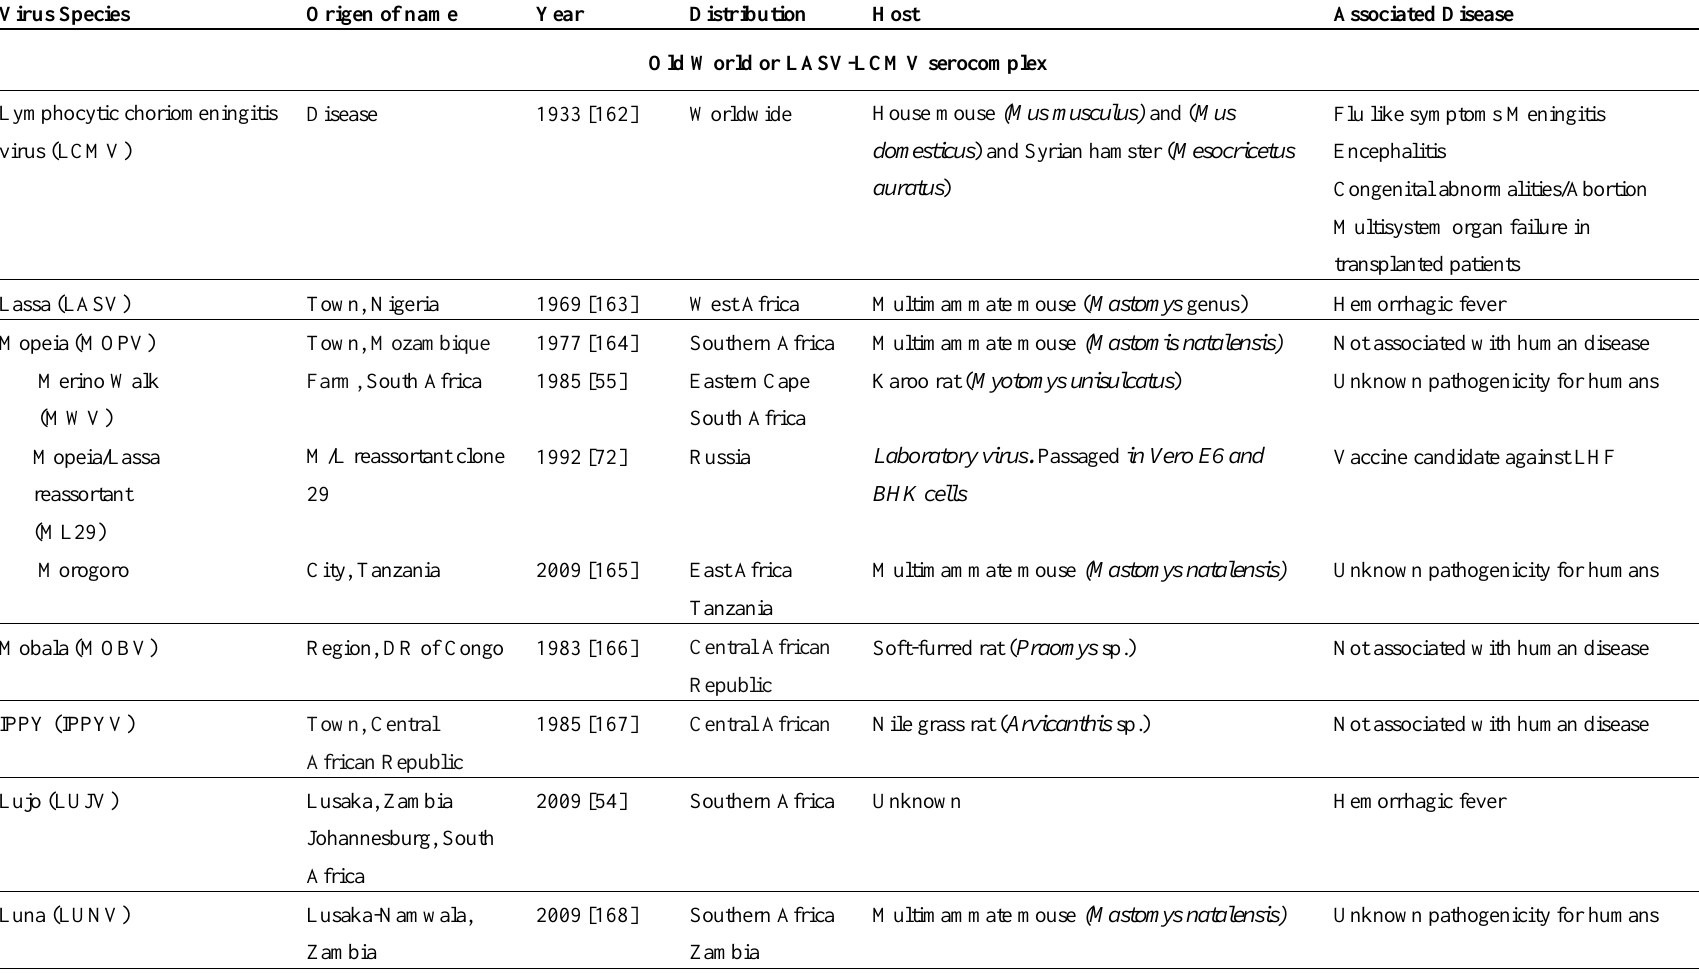
Supplementary Table 1. List of all isolated arenavirus and their name, year of isolation, geographic distribution, reservoir hosts, and associated human diseases. The arenaviruses are divided into two serocomplexes: Old World and New World and based on the viral nucleocapsid protein gene sequences the NW viruses are divided into three phylogenetic